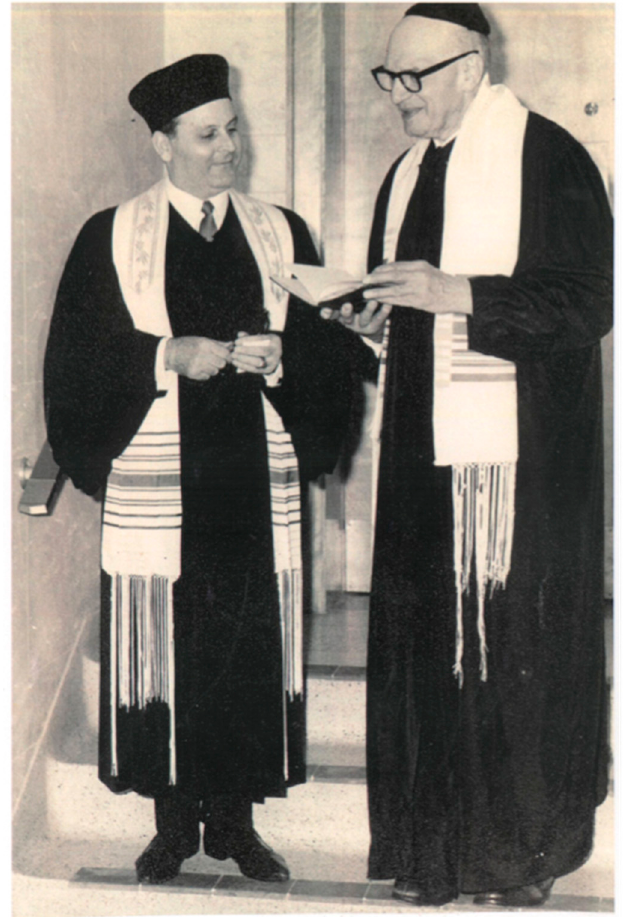
Figure 3. Cantor (Hazzan) Salomon Amzallag with Rabbi Solomon Frank at the Spanish and Portuguese Synagogue. (Courtesy of Yolande Amzallag, Foundation Samy Elmaghribi).